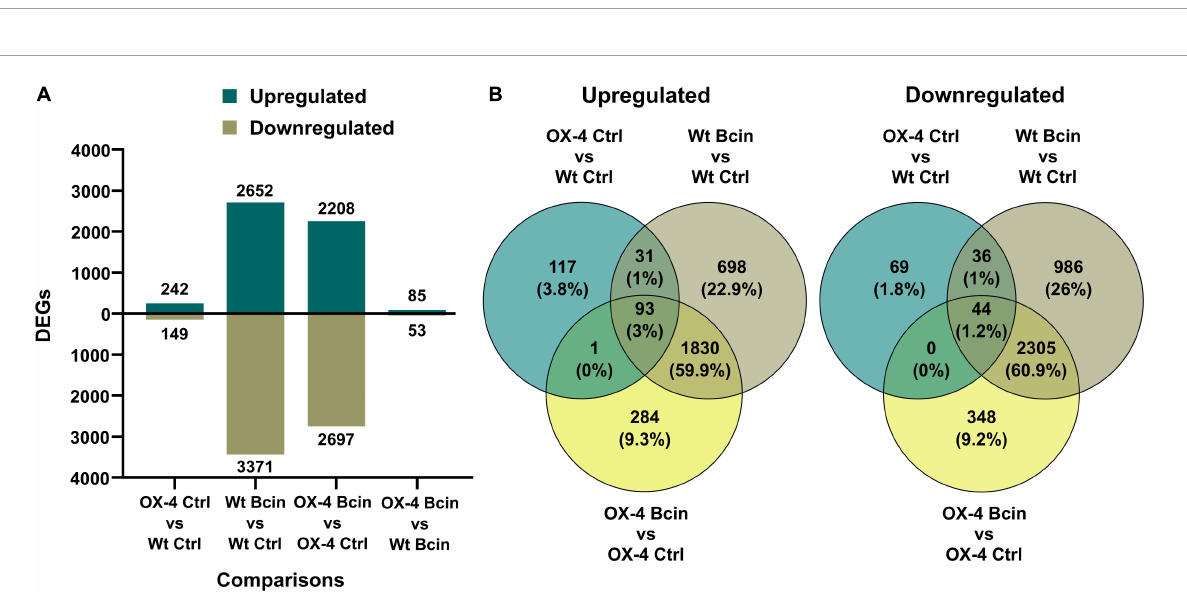
FIGURE4 Differentially expressed genes of wild type and PpERF24-OX-4 overexpressing line during control treatment and B. cinerea infection. (A) Number of differentially expressed genes (DEGs), up- and downregulated, in wild type vs. PpERF24-OX-4 (OX4) tissues treated with water (Ctrl), and wild type (Wt) and PpERF24-OX-4 tissues inoculated with B. cinerea (Bcin) vs. water-treated tissues at 24 hpi. (B) Venn diagram of B. cinerea -responsive P. patens genes in wild-type and PpERF24-OX-4 plants and PpERF24-OX-4 vs. wild-type control tissues. Genes were considered as DEGs when | log2 FC| ≥ 1 and FDR ≤